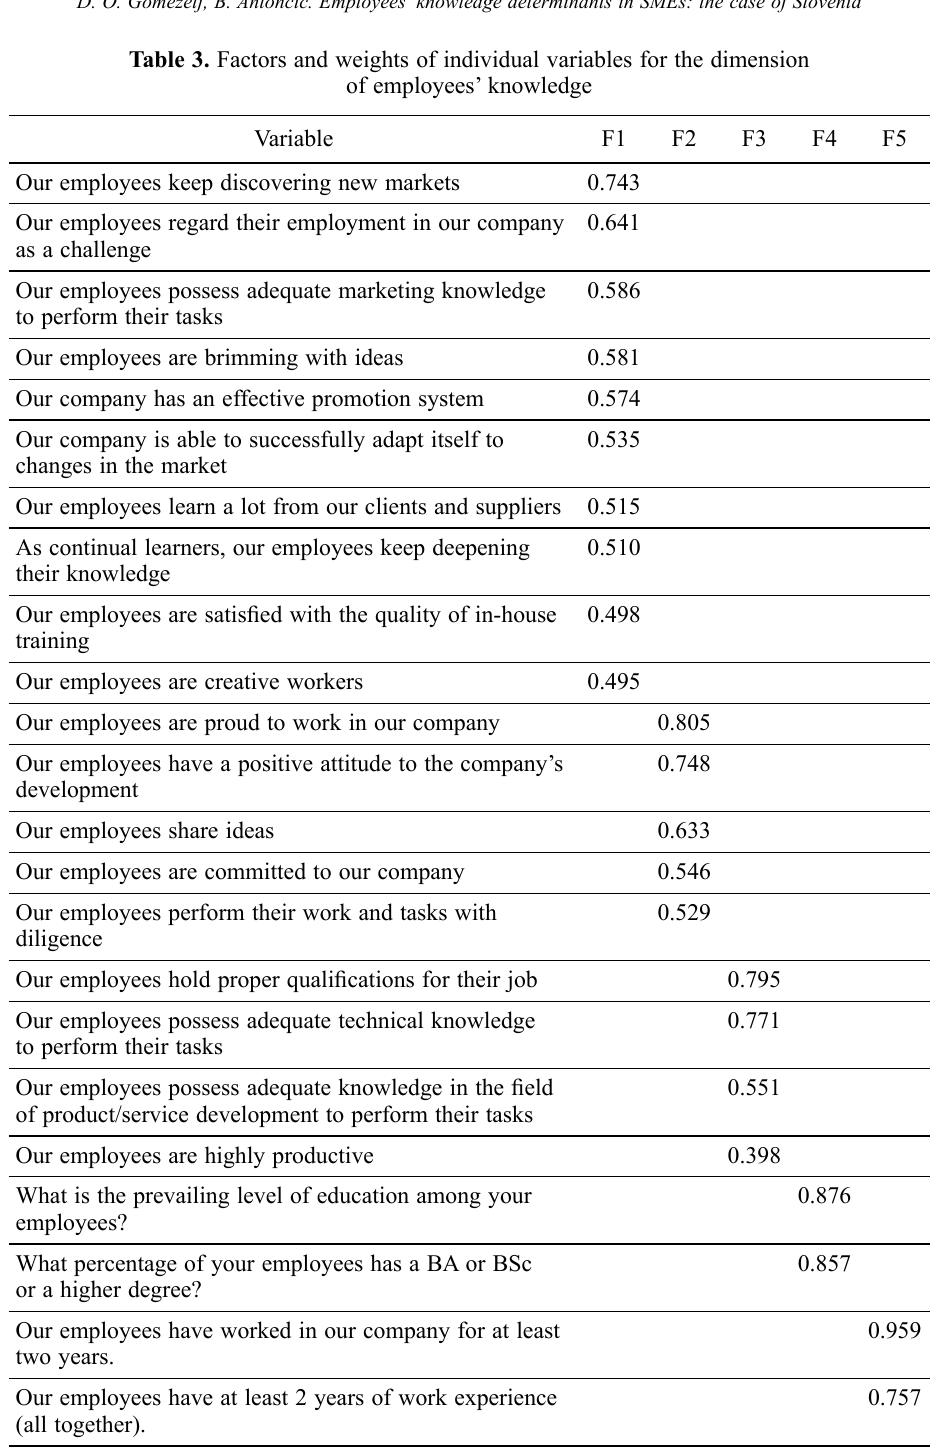
Table 3. Factors and weights of individual variables for the dimension of employees’